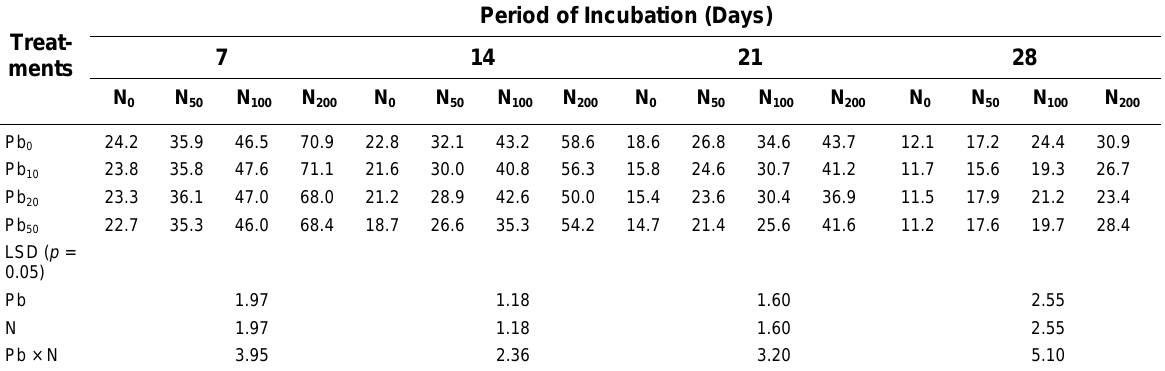
Effect of Different Levels of Pb and N on the Changes in NO -N (mg kg –1 ) Content in Soil under 3 Saturated Condition Period of Incubation (Days) Treat- 7 14 28